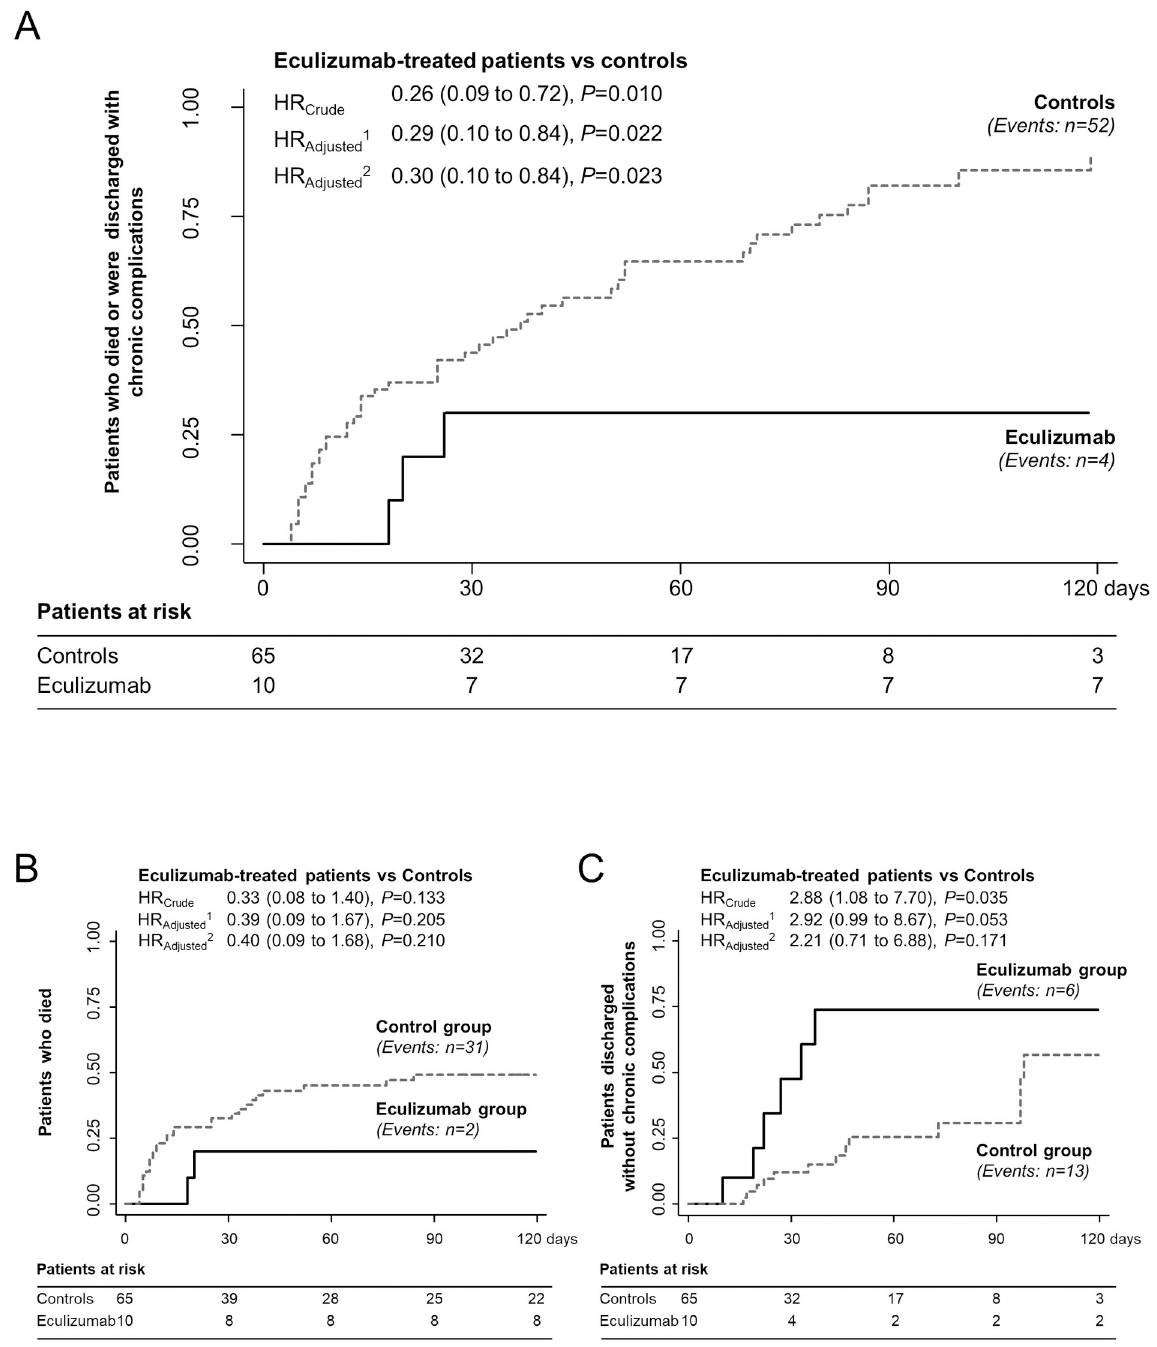
Fig 4. Kaplan-Meier curves for the combined endpoint of mortality or discharge with chronic complications, and for mortality as a single endpoint and discharge without chronic complications in eculizumab-treated patients and controls. Kaplan-Meier curves show the proportion of eculizumab-treated patients and controls who reached the combined endpoint of mortality or discharge with disabling chronic complications (A), mortality as a single endpoint (B) or discharge without chronic complications (C) during the observation period. Hazard ratios (HRs) and 95% confidence intervals are crude and adjusted for sex and age classes (model 1), or for sex, age classes and baseline serum creatinine (model 2). The number of patients at risk is shown in the bottom table. Black continuous line, eculizumab group; grey dashed line, control